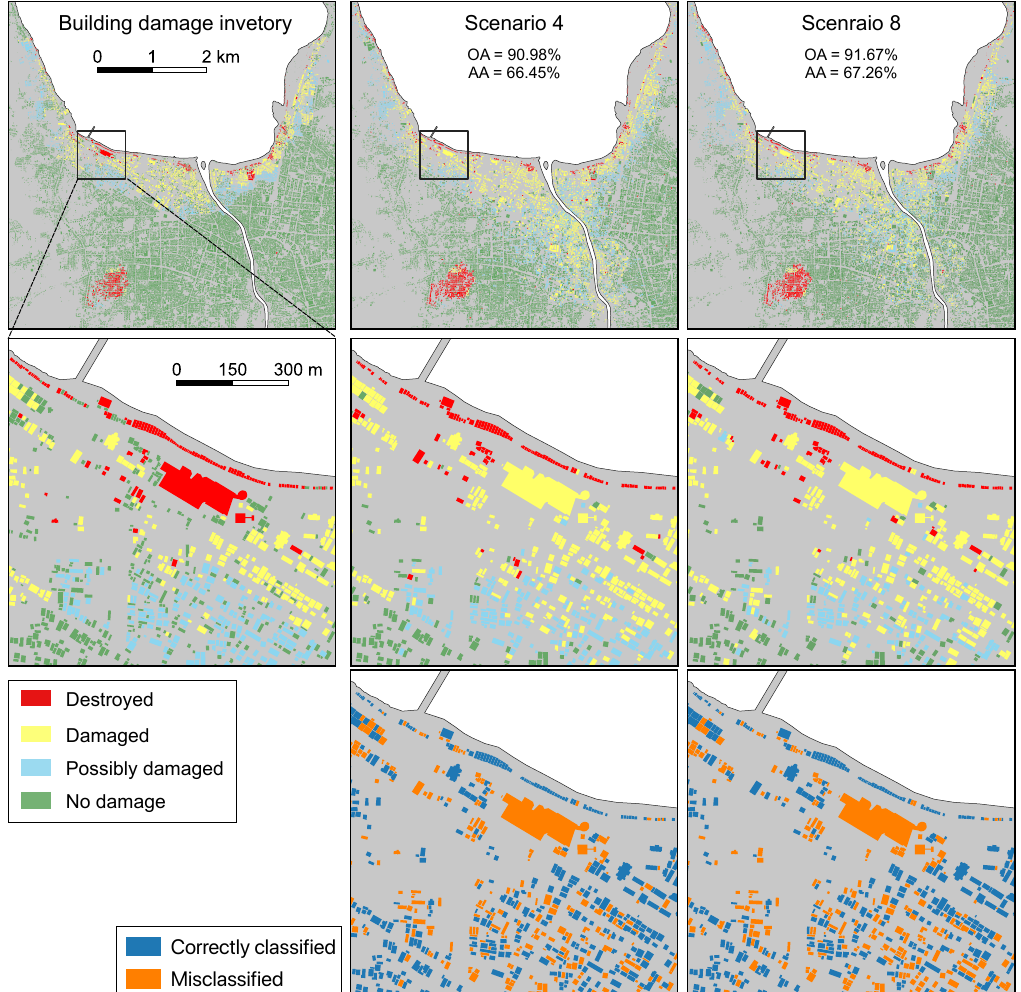
Figure 7. Comparison of building damage mapping from Scenario 4 (only multi-source post-event dataset) and Scenario 8 (multi-source pre- and post-event dataset) obtained from the CCF classifier. Left panels show the rasterized building damage inventory after post-processing using point-data from the Copernicus project and building polygons from OSM. Bottom panels show color-coded maps of the correctly classified and